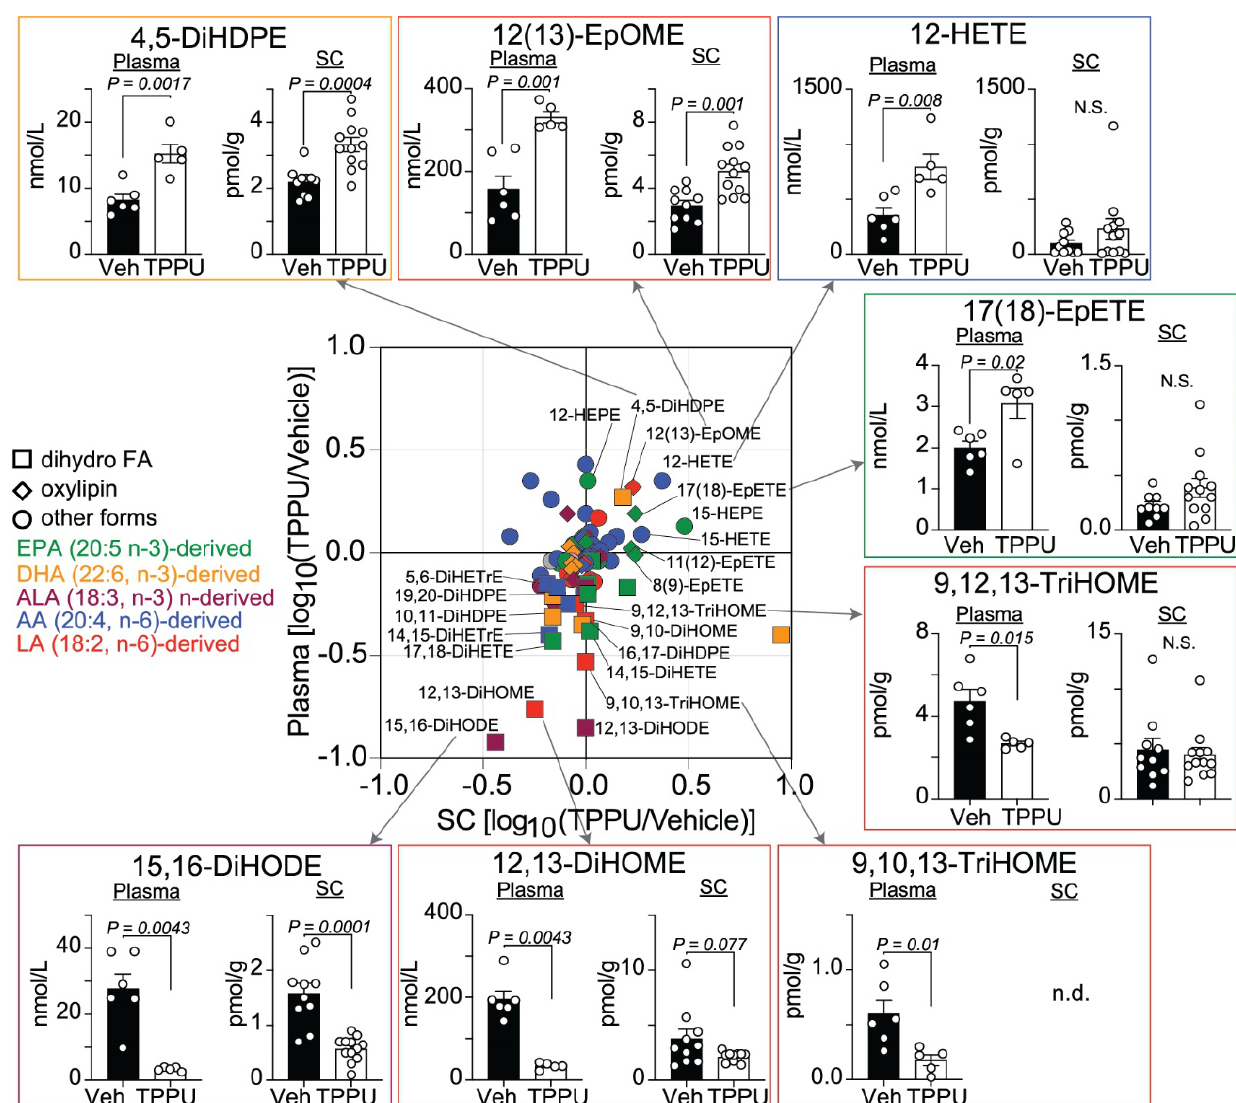
Figure 5. Differential lipid profiles of TPPU-treated vs. vehicle-treated EAE mice. The scatter plot shows the effect of TPPU on lipid levels in EAE SCs (x-axis) and plasma (y-axis). Each symbol represents lipid species coded by color and shape. Representative lipids are displayed as bar graphs. P values were determined by t-test or Mann–Whitney U test. N.S., non-significant. n.d., not detected.